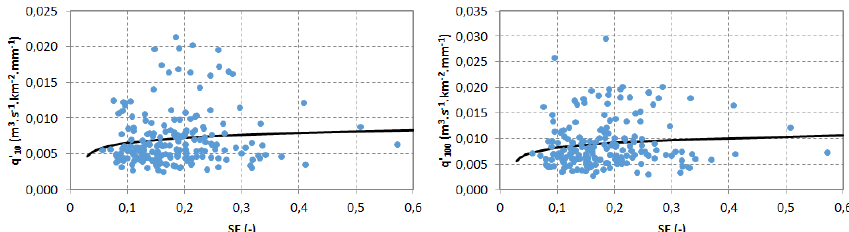
Figure 7. Relationship between catchment average shape factor and peak discharge value per unit area and unit precipitation total for T = 10 years (left panel) and T = 100 years (right panel) with fitted lines following Eq. (2).